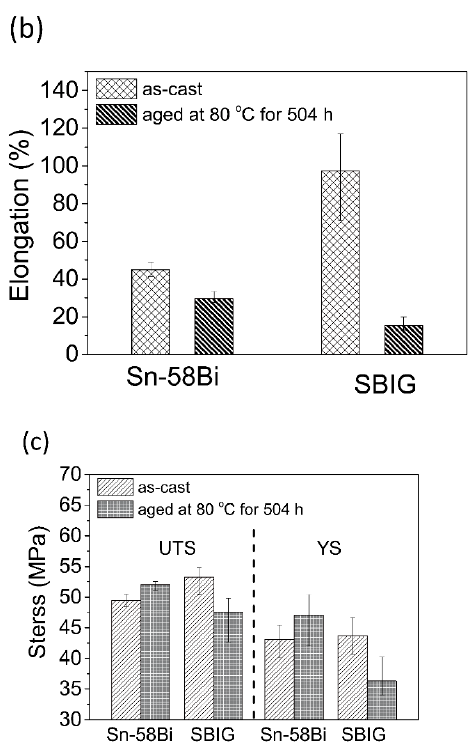
Figure 8. ( a ) The stress-strain (SS) curves of the as-cast and 80 ◦ C-annealed eutectic Sn–58Bi and SBIG samples in tensile tests, respectively. ( b ) The elongation, and ( c ) ultimate tensile strength (UTS) and yield strength (YS) of as-cast and 80 ◦ C-aged eutectic Sn58Bi and SBIG samples.